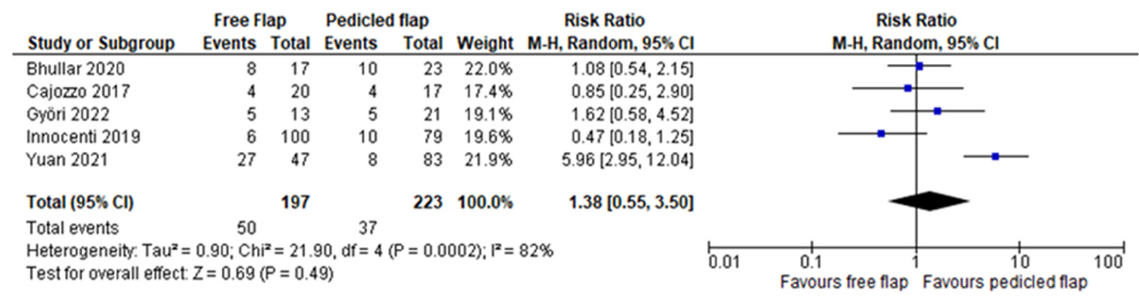
Figure 4. Overall complications meta-analysis [13,15,16,19–21].